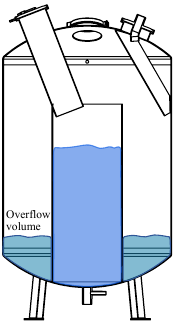
Figure 3. Mechanical drawing of the pumping station